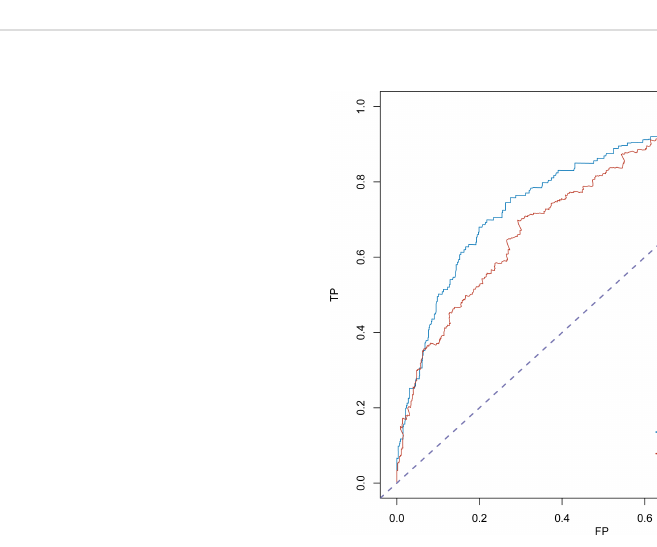
FIGURE 6 ROC curve analysis to predict 1- and 3-year OS rates in the external validation